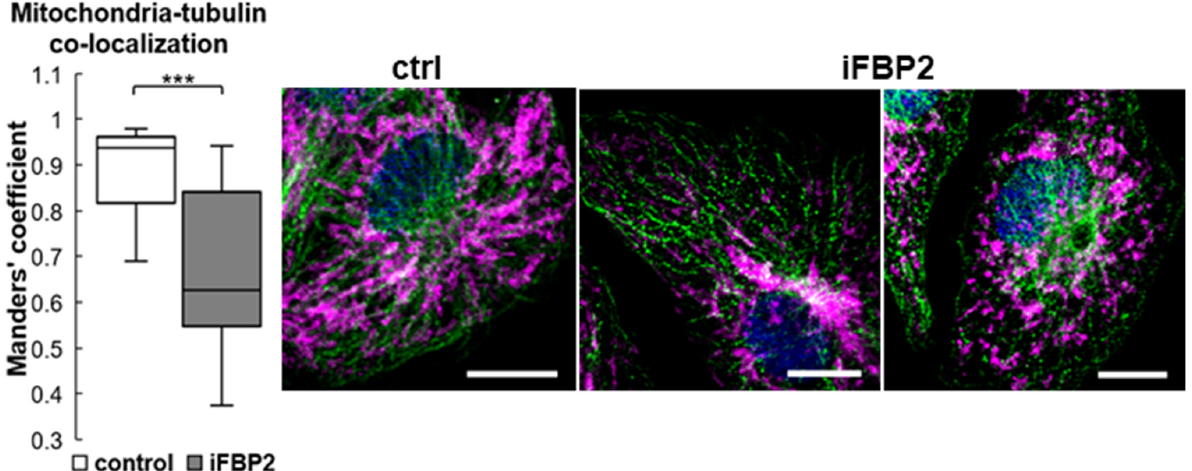
Figure 8. Tetramerization of FBP2 correlates with a decrease in mitochondria-tubulin co-localization. Control (ctrl)—untreated HL-1 cells; iFBP2—FBP2 tetramerizing agent-treated cells. In zoomed microscopic images, mitochondria are presented in magenta, tubulin in green and the nucleus in blue. Measurements were taken from 12 randomly selected areas from each microscopic slide. Data are presented as median and interquartile range. *** p < 0.001. Bar = 10 µm. In neurons, both the Thr231 residue of Tau and the MAP1B protein are primary